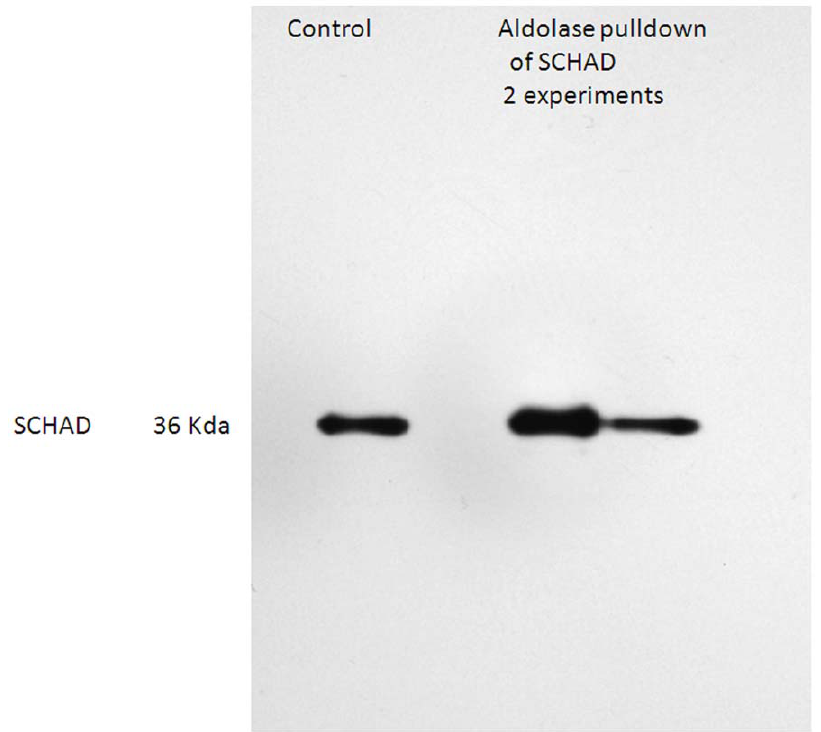
Figure 1. Western blot of SCHAD following pulldown with fructose bisphosphate aldolase. Lane 1, homogenized liver SCHAD control, Lane 2 albumin blank, Lanes 3 and 4 results from 2 separate pulldown experiments showing a normal sized mitochondrial SCHAD.